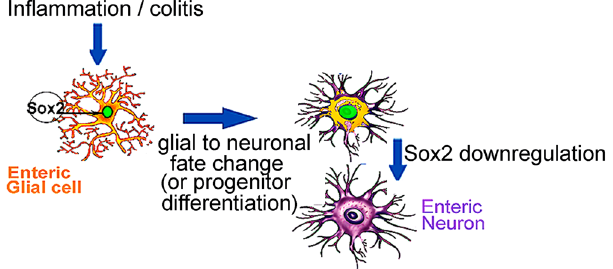
Figure 11. Inflammation induced early neurogenesis. In the present work, we show that inflammation can cause a rapid glial-to-neuronal fate change or neural progenitor differentiation, which can be identified by an expanding neuronal mass and a new population of Sox2 + Hu + neurons. We hypothesize that these then downregulate Sox2 as they become mature